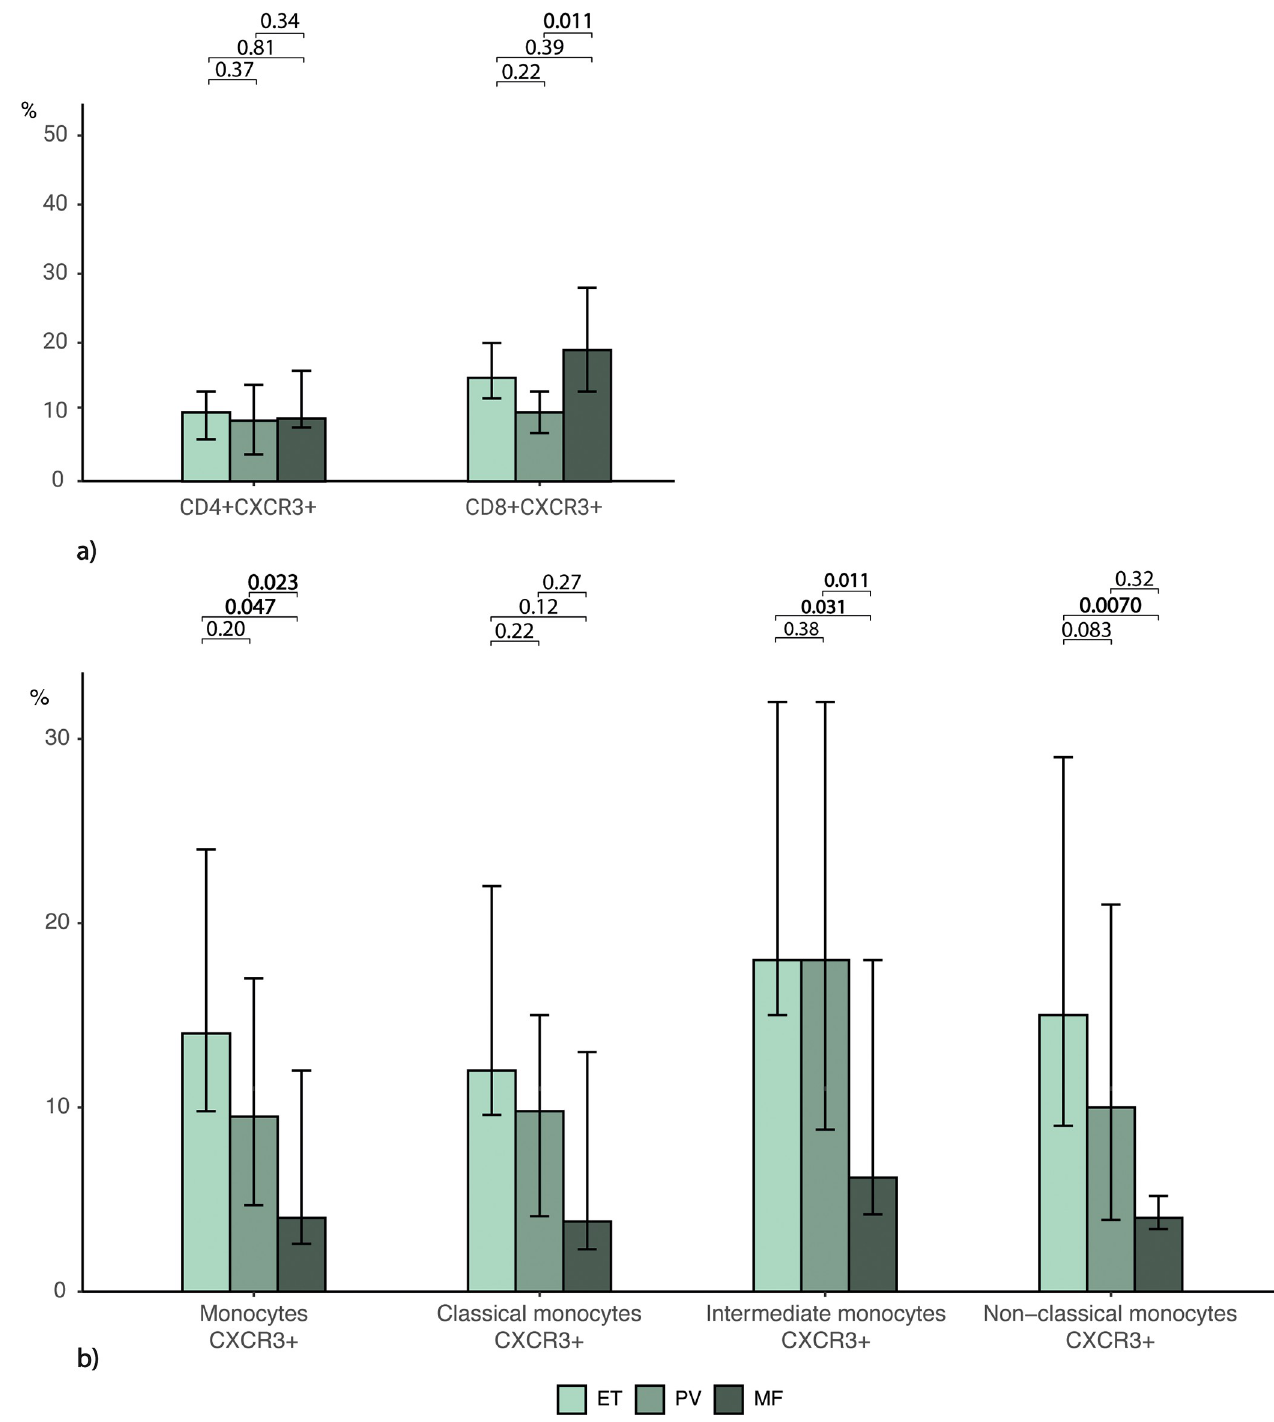
Fig 3. CXCR3 expression on leukocytes in MPN subtypes showing decreasing levels of CXCR3 on monocytes over the MPN biological continuum in monocytes. Median frequency (%) of leukocytes and leukocytes expressing CXCR3 in patients with essential thrombocythemia (ET), polycythemia vera (PV), and myelofibrosis (MF) a) Expression of CXCR3 on T cells. b) Expression of CXCR3 on monocytes. Bars represent the interquartile range. Statistical comparison between groups: Kruskal Wallis or if the outcome depended on age, robust linear regression. Wilcoxon rank-sum test for multiple comparisons. Significant P-values are shown in